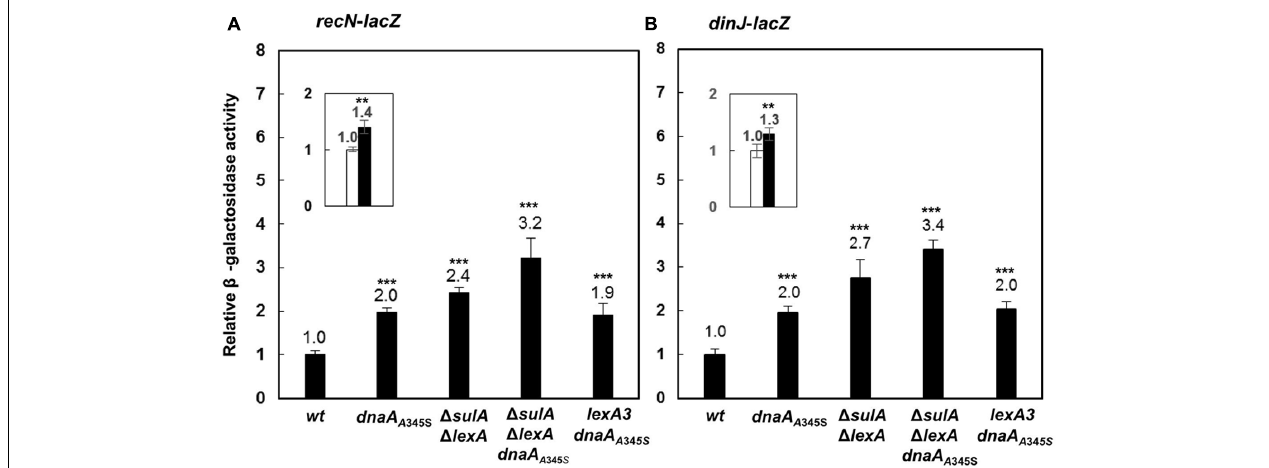
FIGURE 7 | The DnaA and LexA proteins reppress expression of the recN or dinJ gene independently. The wild-type, dnaA A345S , (cid:49) sulA (cid:49) lexA , (cid:49) sulA (cid:49) lexA dnaA A345S and lexA 3 dnaA A345S cells carrying recN - lacZ (A) or dinJ - lacZ (B) fusion on their chromosomes were exponentially grown in ABTGcasa medium at 37 ◦ C. The β -galactosidase activity from recN - lacZ (13 U for wild-type) (A) or dinJ - lacZ (13 U for wild-type) (B) fusion in the cells was determined as described in the legend to Figure 1 . The insets indicate the relative expression of renN-lacZ or dinJ - lacZ in the (cid:49) sulA (cid:49) lexA dnaA A345S cells against that in the (cid:49) sulA (cid:49) lexA cells. The values shown at top of the bars are the average of three individual experiments, and the standard errors are shown. ∗∗∗ Stands P -value ≤ 0.01, ∗∗ for 0.01 < P -value ≤ 0.05, ns represents P -value >